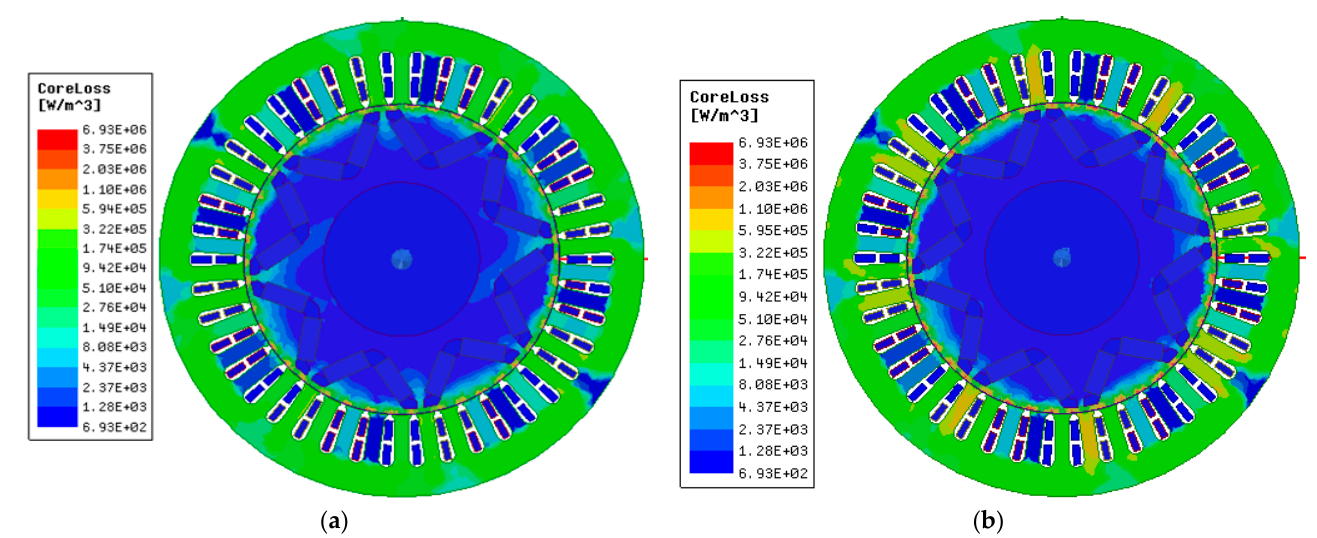
Figure 14. Iron loss. ( a ) Unidirectional coupling; ( b ) bidirectional coupling.